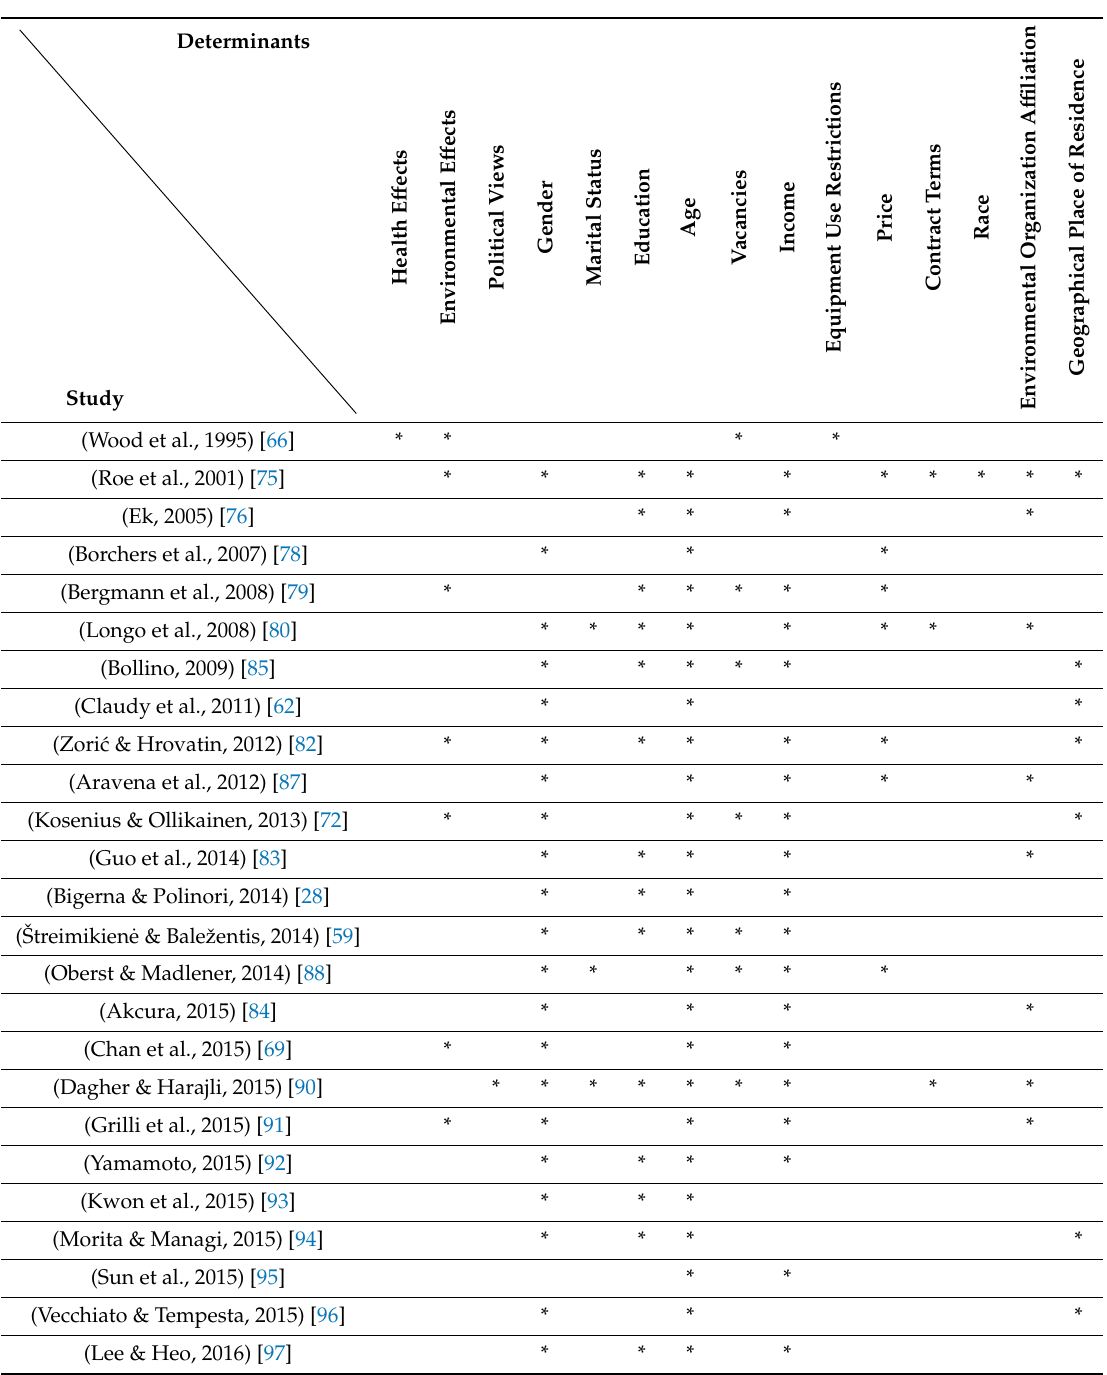
Table 2. Common determinants or socio-demographic factors a ff ecting people’s WTP for renewables.